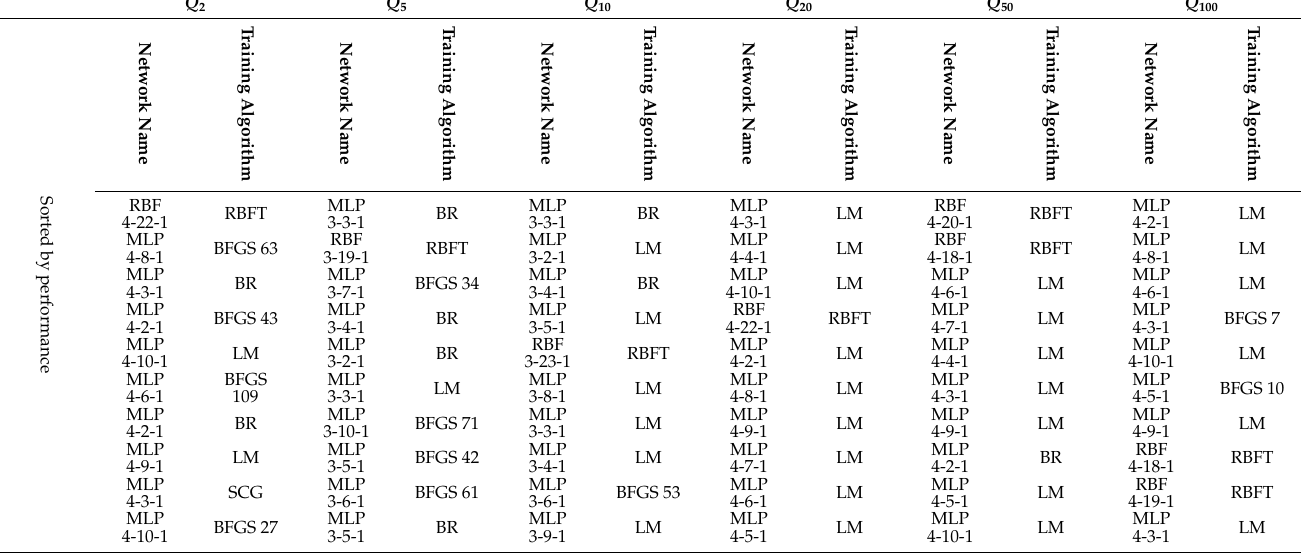
Table A1. Ten best-performing ANN models for different flood quantiles.